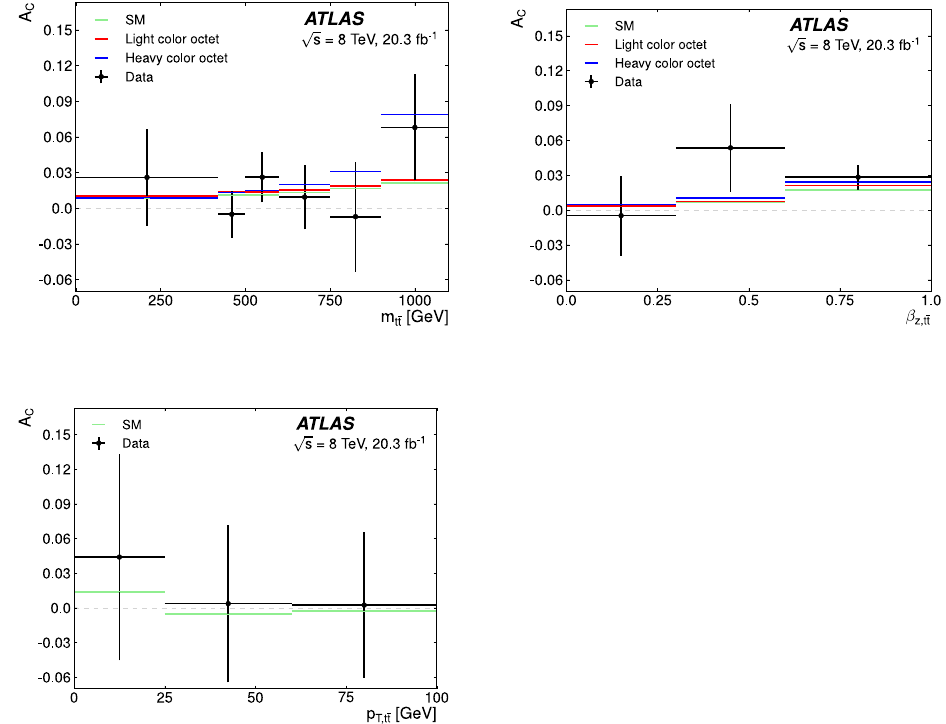
Figure 14. Measured A t ¯ t and two benchmark BSM scenarios